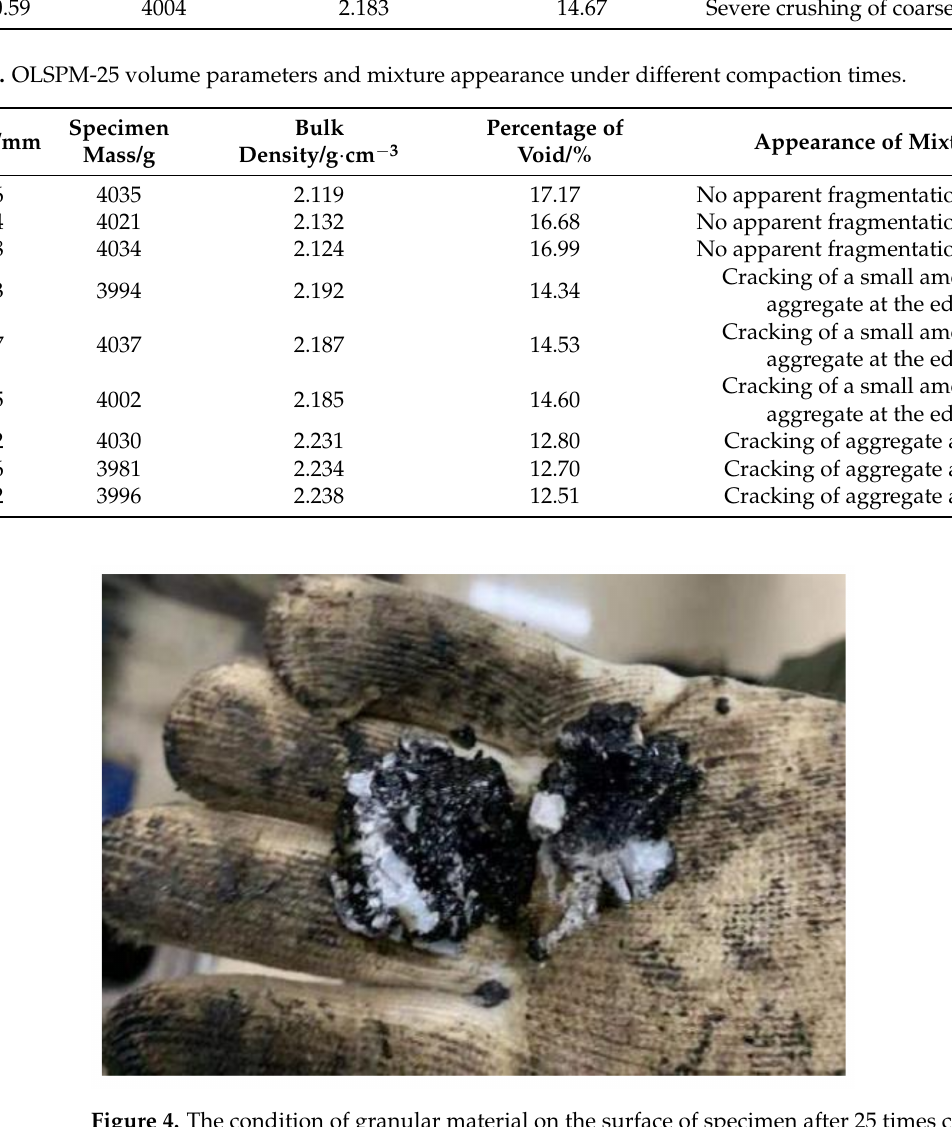
Figure 4. The condition of granular material on the surface of specimen after 25 times compaction. Considering that the change between different compaction times and bulk density and height of the mixture can be recorded in the process of rotary compaction, this paper analyzes the data recorded in the first group of 50 compaction times so as to determine the reasonable compaction times of OLSPM. The relevant data are shown in Figure